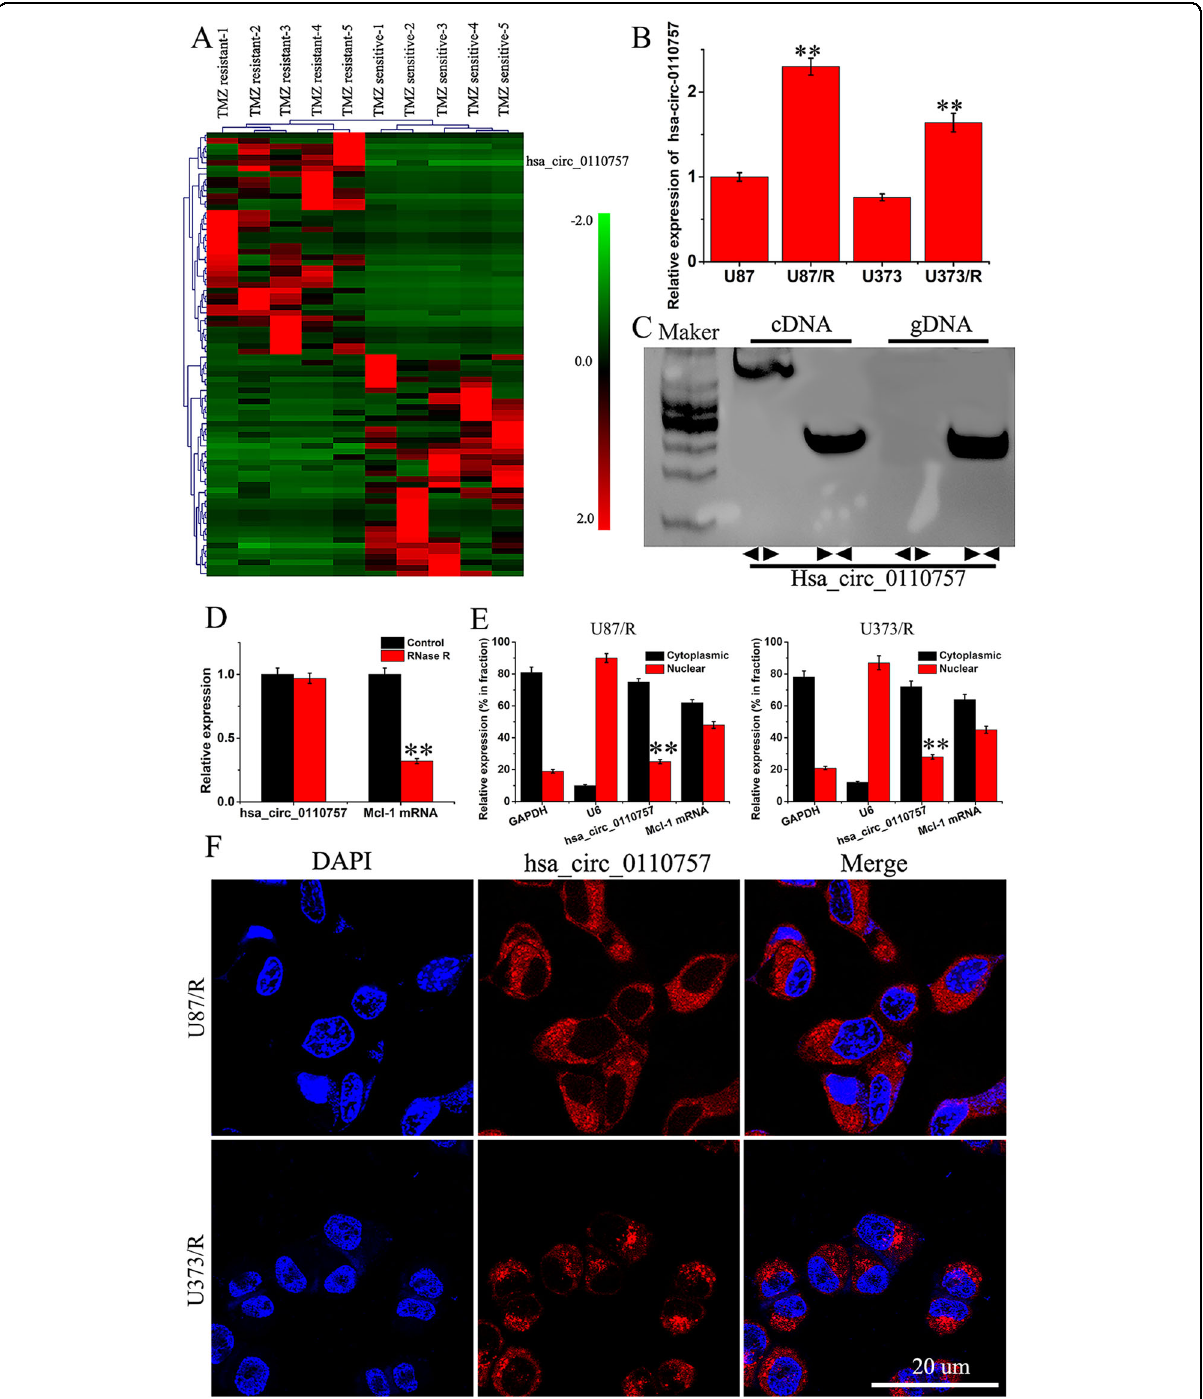
Fig. 1 The expression of hsa_circ_0110757 in TMZ-resistant glioma tissues and cells. A The circRNA expression pro fi le in fi ve TMZ-resistant glioma tissues and fi ve TMZ-sensitive glioma tissues by high-throughput sequencing. B The expression of hsa_circ_0110757 in U87, U87/R, U373, and U373/R cells. C Hsa_circ_0110757 was veri fi ed in U87/R by RT-PCR. hsa_circ_0110757 was ampli fi ed by divergent primers in cDNA but not in gDNA. D The stability of hsa_circ_0110757 and Mcl-1 RNA after enzymolysis with or without RNase R. E The distribution of hsa_circ_0110757 and Mcl-1 RNA in the nuclear and cytoplasmic fractions of U87/R and U373/R cells. U6 was used for nuclear fraction positive control, GAPDH was used for cytoplasmic fraction positive control. F The distribution of hsa_circ_0110757 was detected by fl uorescence in situ hybridization (FISH) in U87/R and U373/R cells. ** P <